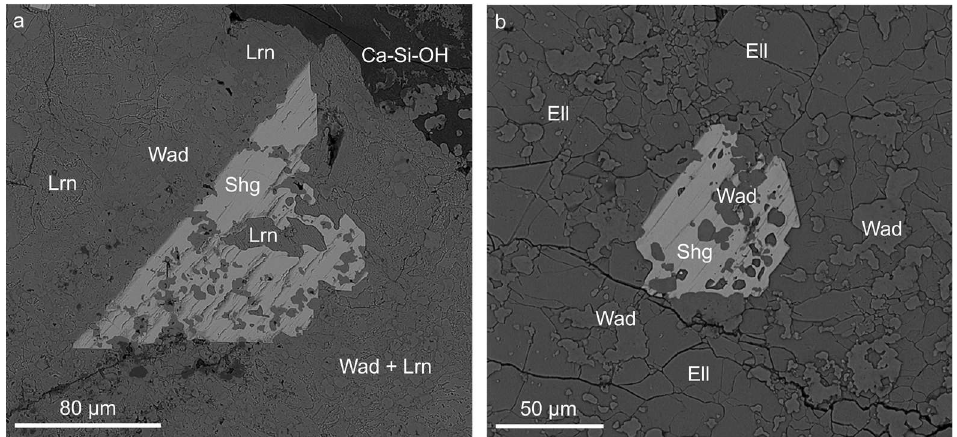
Figure 5. ( a ) Sharyginite crystal in larnite-wadalite rock from the Upper Chegem volcanic Caldera; ( b ) Poikilitic euhedral crystal of sharyginite with wadalite inclusions. BSE images.